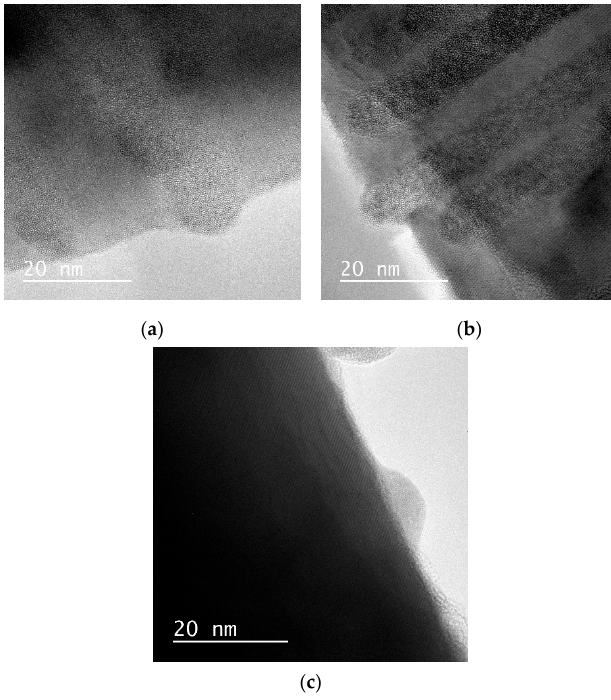
Figure 3. Bright field images of hillocks induced in ( a ) LiNbO 3 , ( b ) ZrSiO 4 , and ( c ) Gd 3 Ga 5 O 12 irradiated with 200 MeV Au 32+ at an oblique incidence angle. The images were taken at relatively high magnification.